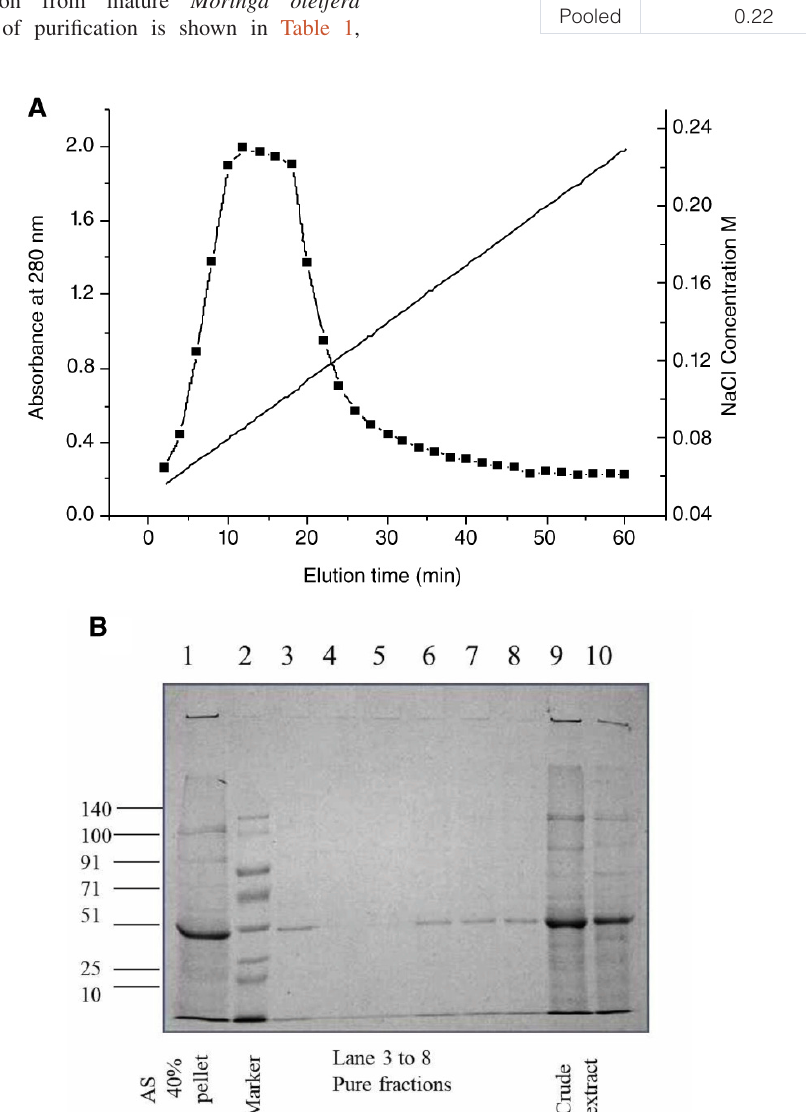
Figure 1. A . Chromatogram for the purification of protein from Moringa oleifera shows the elution time versus absorbance at 280 nm and the corresponding NaCl gradient profile (ranging from 0.04M to 0.25M) for maximal elution B . SDS PAGE of the crude extract and fractions after purification by DEAE cellulose ion exchange chromatography. Lane 1 shows extract after 40% ammonium sulphate precipitation, lane 2 shows the prestained molecular weight marker from GCC biotech marking 140, 100, 91, 71, 51, 25 and 10 kDa bands, lanes 3 to 8 represent fractions after column purification, lanes 9 and10 show the bands from crude leaf